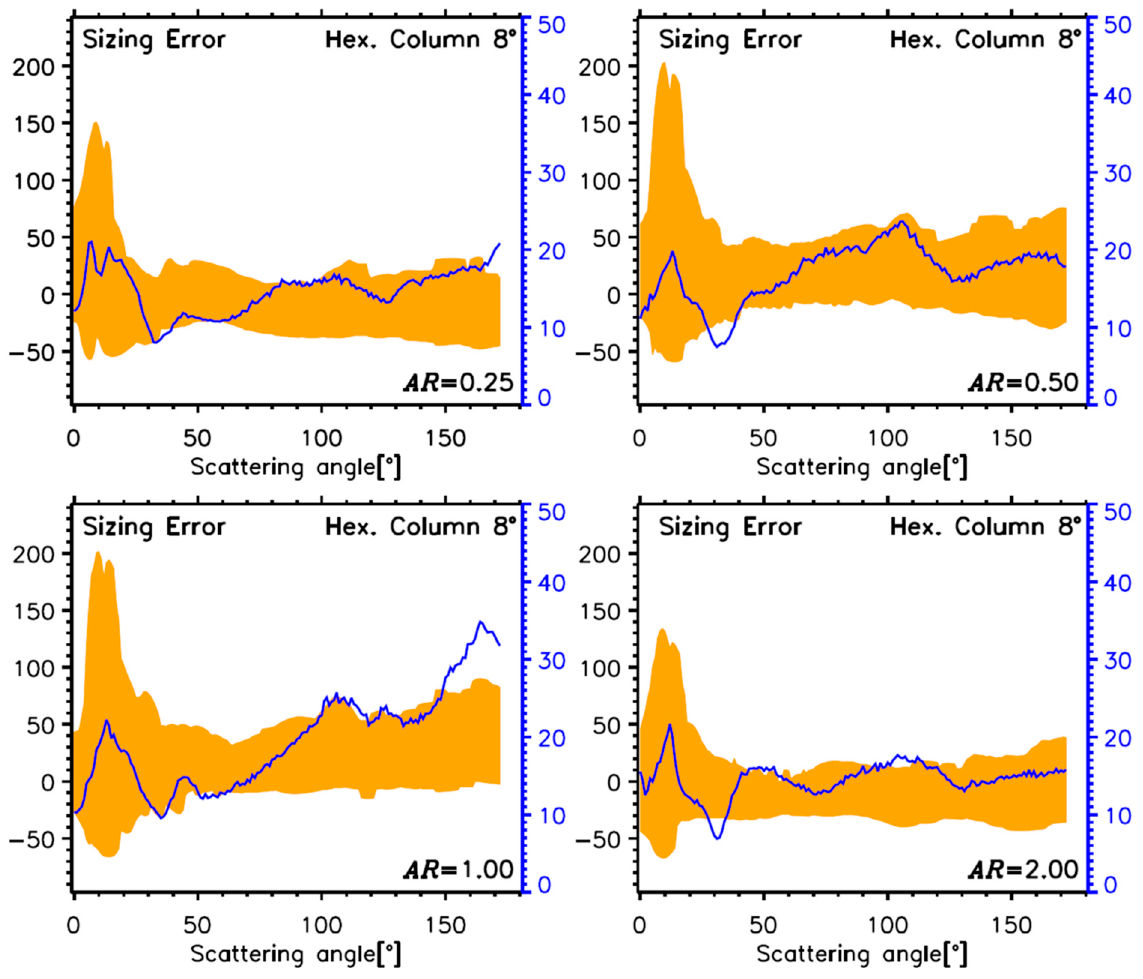
Figure 16. The same as Figure 15, but for 8° resolution of scattering angles.